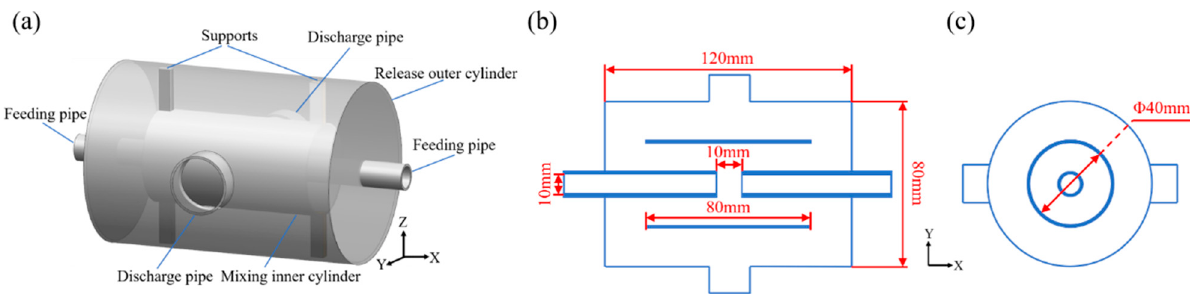
Figure 1. Schematic diagrams of the CFPCD: ( a ) stereogram view, ( b ) center cross section, and ( c ) center longitudinal section.